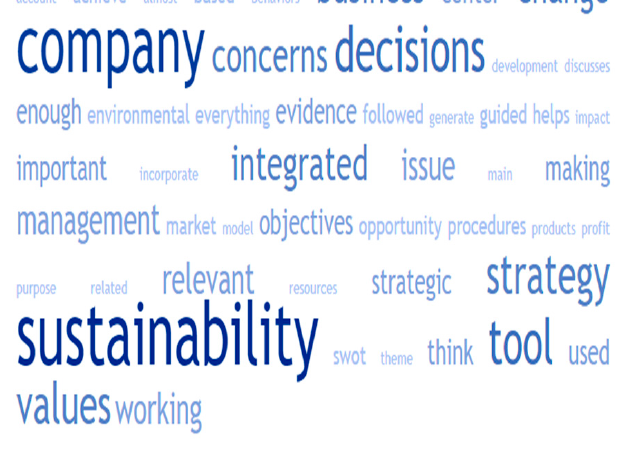
Figure 4. Word Figure 4. Word cloud. Figure 4. Word cloud.